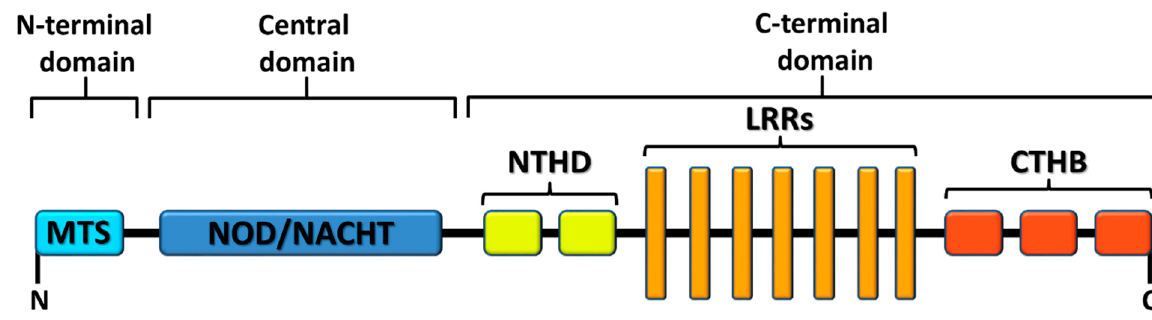
Figure 1. Schematic representation of NLRX1 structure. CTHB: C-terminal three-helix bundle; LRRs: leucine-rich repeats; MTS: mitochondrial targeting sequence; NACHT: domain conserved in NAIP, CIITA, HET-E and TP1; NOD: nucleotide-binding oligomerization domain; NTHD: N-terminal helical domain.